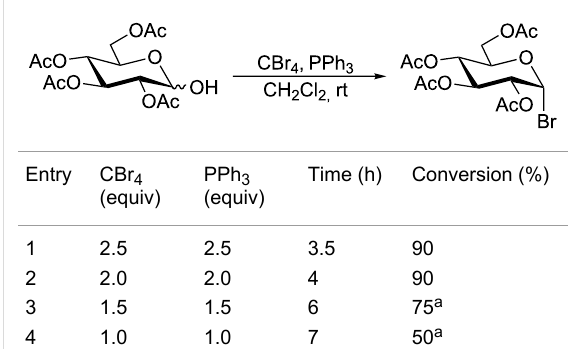
Table 2: Optimization of the in situ conversion of glycosyl hemiacetal to glycosyl